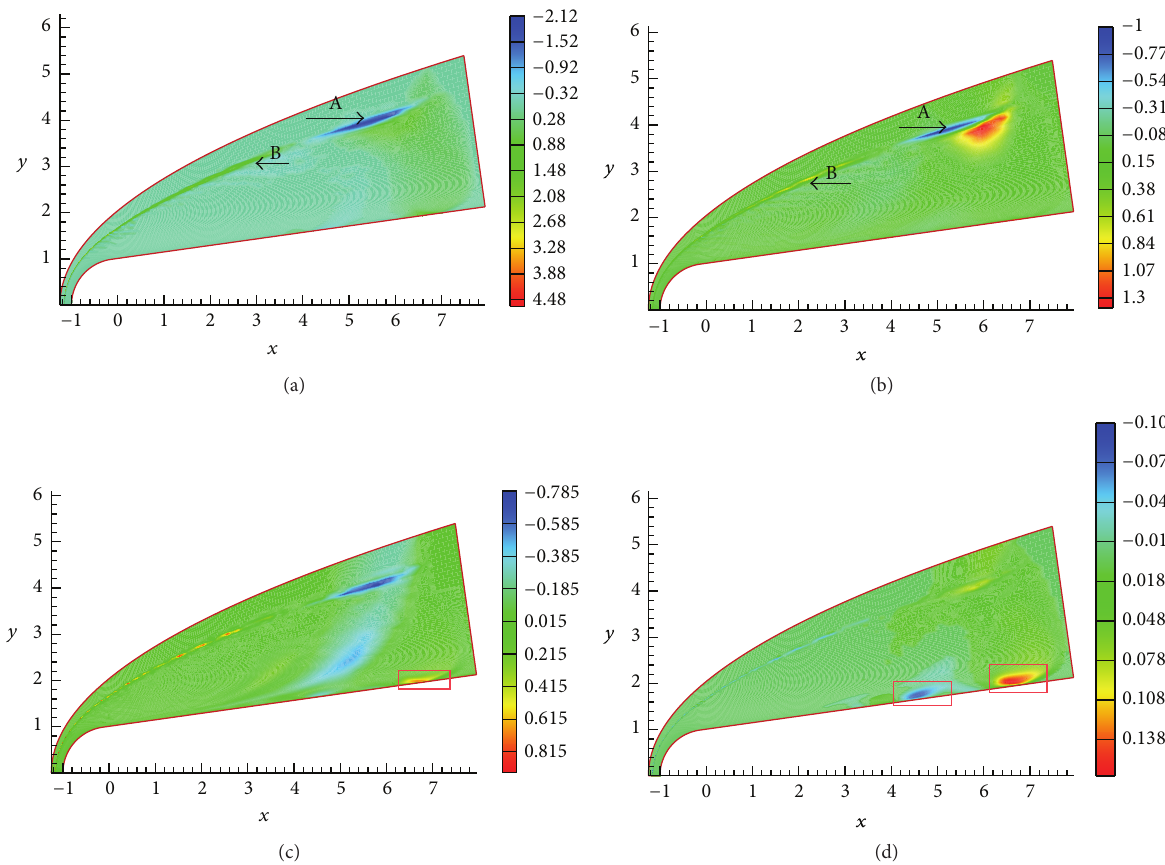
Figure 5: Contours of pressure 𝑃 󸀠 (𝑥,𝑦,𝑡) , density 𝜌 󸀠 (𝑥,𝑦,𝑡) , temperature 𝑇 󸀠 (𝑥,𝑦,𝑡) , and velocity